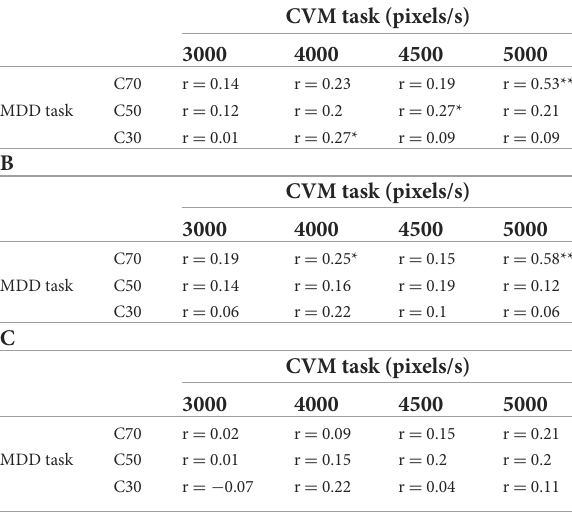
TABLE 2 Correlation coefficients for the scores in the (A) MDD task and CVM task, (B) MDD task for a target that appeared in the right-side visual field and CVM task, and (C) MDD task for a target that appeared in the left-side visual field and CVM